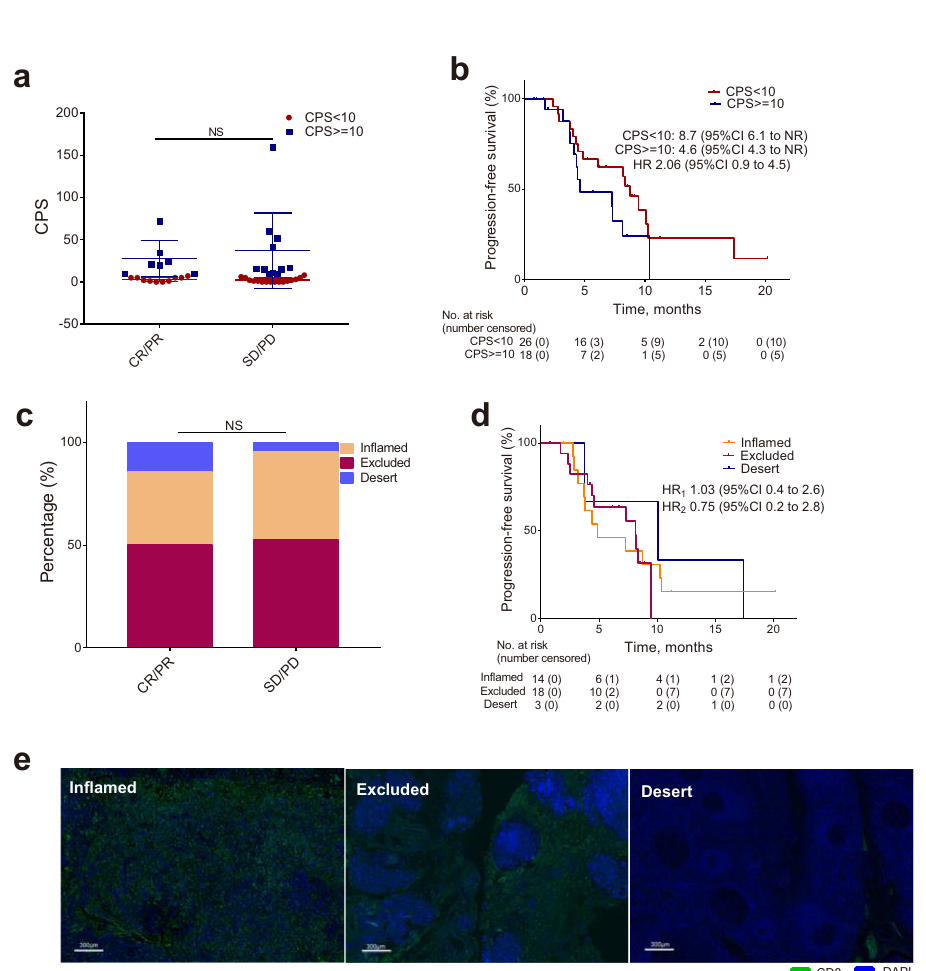
Fig. 3 Biomarker analysis of TLS and proteomics. a Association between ORR and mean area of TLS, patients with SD/PD ( n = 19) and with CR/PR ( n = 15) biologically independent samples. Calculated by two-tailed t -test, P = 0.011. b Association between ORR (%) and mean area of TLS at cutoff value of 30,000 μ m 2 . Calculated by two-tailed Fisher ’ s exact test, P = 0.014. c Presentative images of TLS stained by multiplex immuno fl uorescence using markers DAPI, CD20, CD4, and CD8. Original magni fi cation, 1× or 10×. TLS staining was performed one time in 34 independent samples with similar results. d Association between response and PML expression level, patients with SD/PD ( n = 18) and with CR/PR ( n = 15) biologically independent samples. Calculated by two-tailed t -test, P = 0.0008. Each dot represents one patient. e Kaplan – Meier estimates of PFS by PML intensity at cutoff value of 139,189 (PML high vs. PML low ). NR, not reached. f Association between response and PLOD3 expression level, patients with SD/PD ( n = 18) and with CR/ PR ( n = 15) biologically independent samples. Calculated by two-tailed t -test, P = 0.003. Each dot represents one patient. g Kaplan – Meier estimates of PFS by PLOD3 intensity at cutoff value of 490,635 (PLOD3 high vs. PLOD3 low ). NR, not reached. * indicates adjusted P -values < 0.05, ** indicates adjusted P -values < 0.01, *** indicates adjusted P -values < 0.001. Aggregate data in a , d and f are represented as means± SD. Source data are provided as a Source Data fi le.